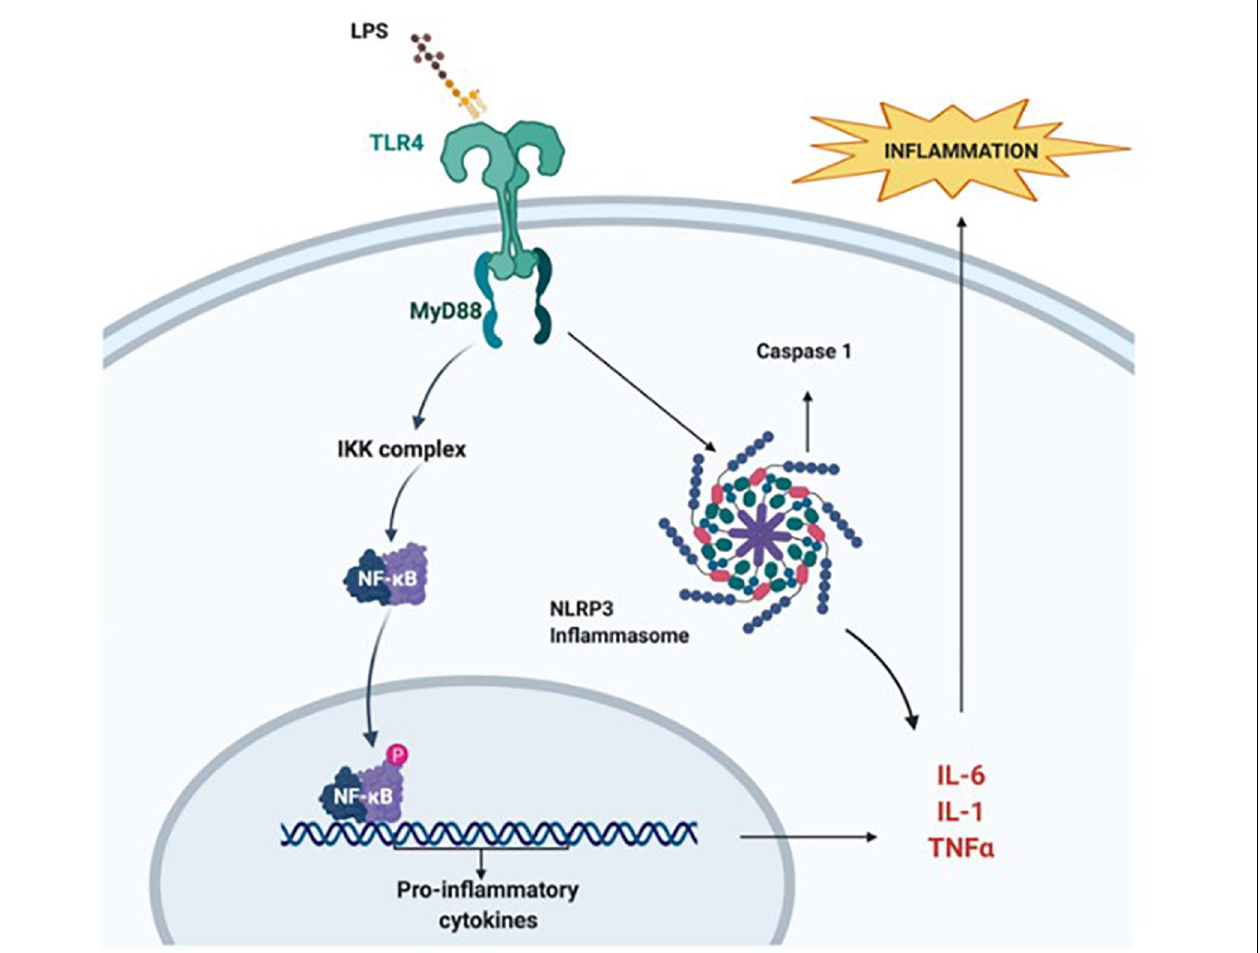
FIGURE 2 | Lipopolysaccharide sensitisation. A bacterial infection sensitises the brain to HI insult via the interaction of LPS and TLR4. This leads to internalisation of NF- κ B, mediated by MyD88. NF- κ B activates the transcription of pro-inflammatory cytokine genes. Simultaneously, the interaction of LPS with TLR4 activates the NLRP3 inflammasome, which also promotes increase in pro-inflammatory cytokine levels and apoptosis. Figure created with